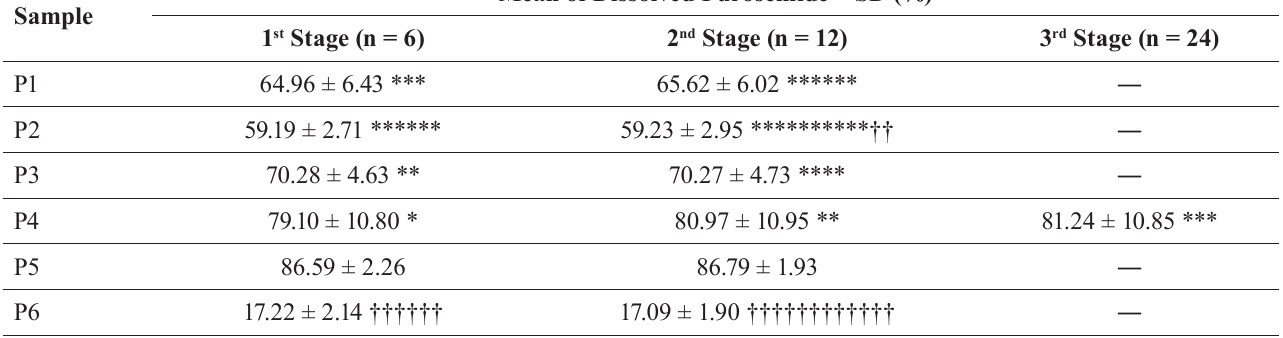
TABLE VI - Mean furosemide dissolution based on the percentage of the amount of furosemide declared on the label for compounded batches (P1 to P7), batches made in-house (T2 and T4) and batch of the reference medicinal product (R) after